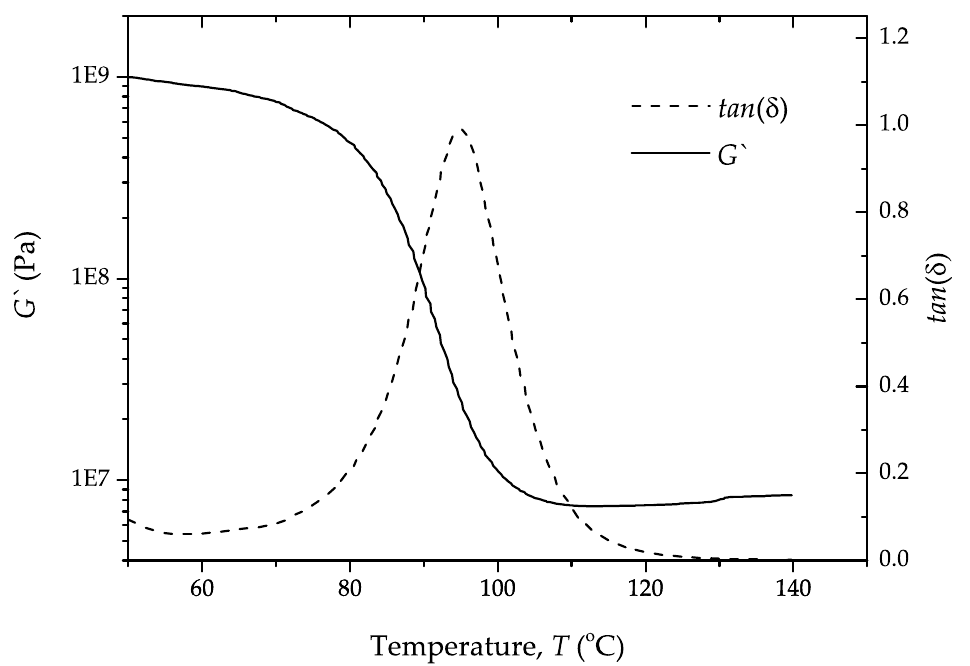
Figure 2. Plot evolution of the storage modulus ( G (cid:48) ) and the damping factor ( tan δ ) of a partially bio-based epoxy resin after curing at 90 ◦ C for 1 h and a post-curing cycle at 150 ◦ C for 0.5 h.